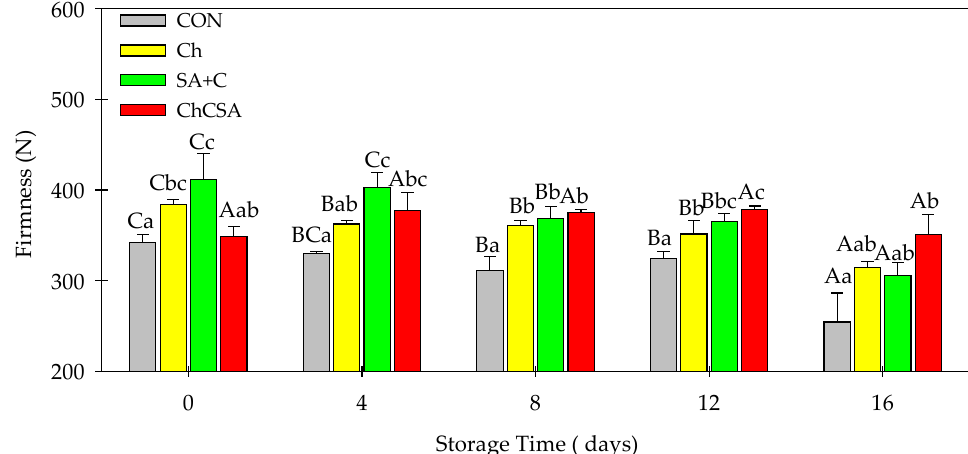
Figure 3. The effect of single-layer and gel coatings on the flesh firmness of fresh-cut purple sweet potatoes. Vertical bars represent means and standard deviation. Bars with different alphabets within the same storage day (lower case) or same treatment group at different storage days (upper case) are significantly different (Tukey’s HSD Test, p ≤ 0.05).